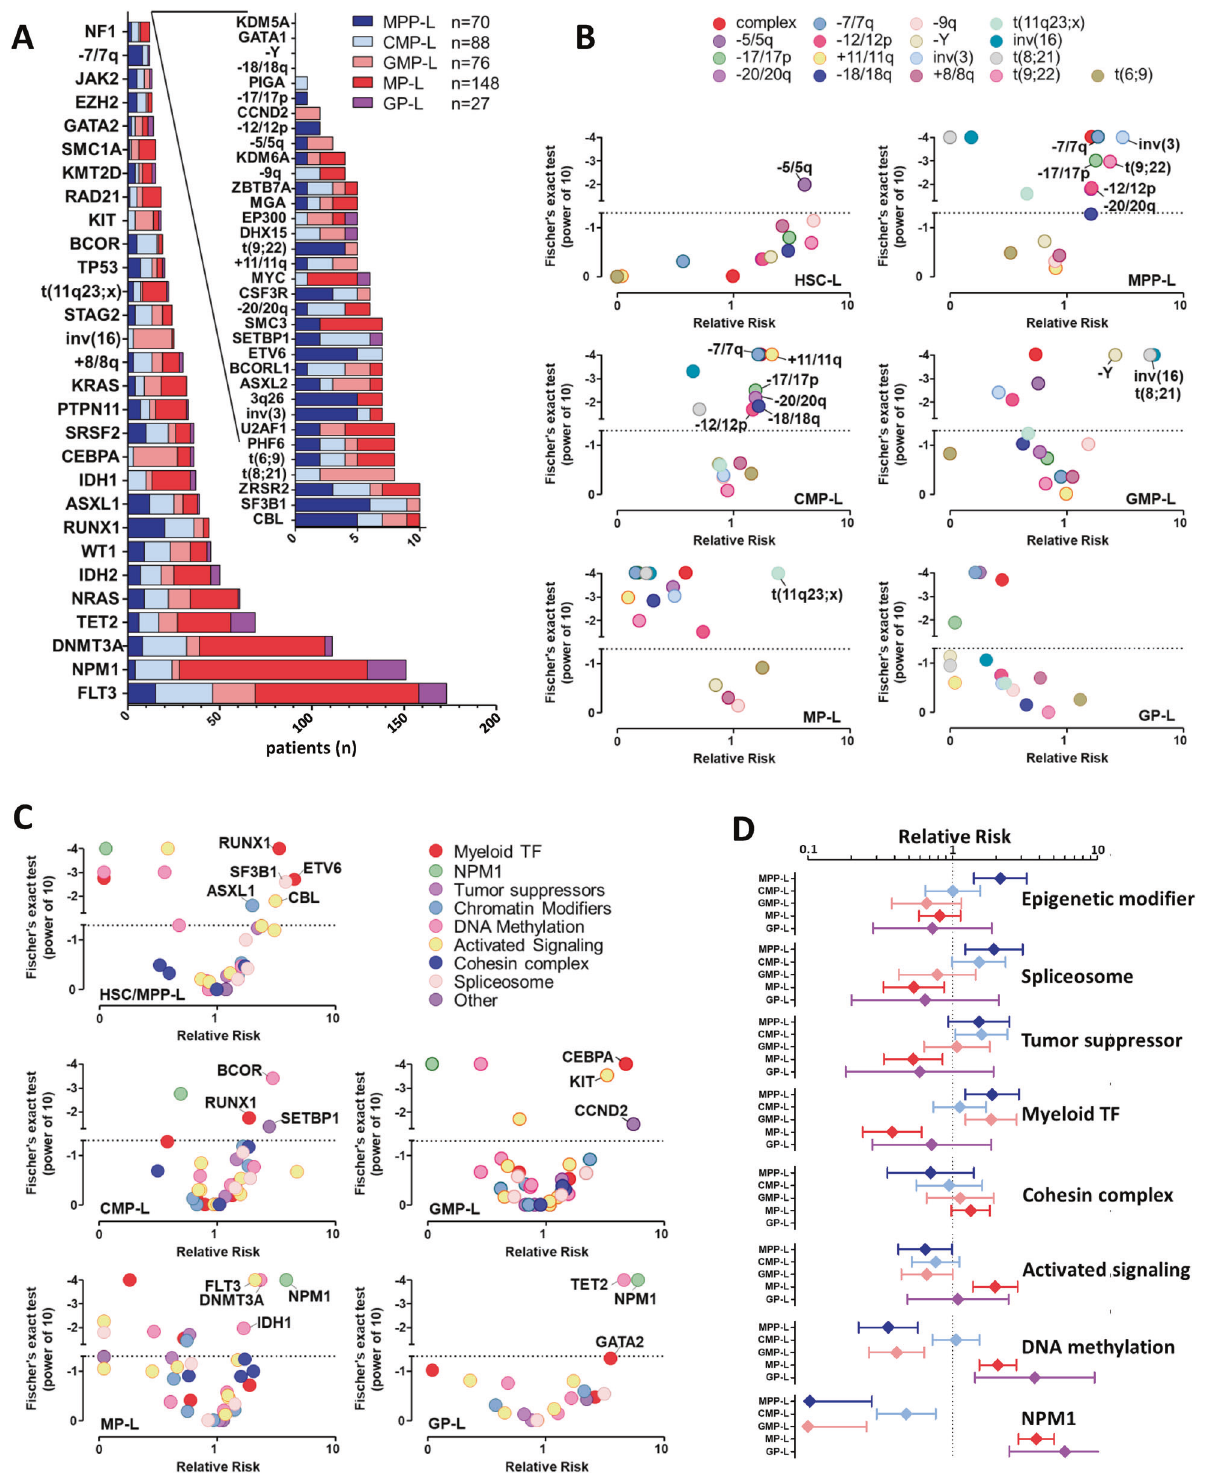
Fig. 4 Distribution of AML mutations and genetic abnormalities according to the SLA. A Number of patients with speci fi c mutations or genetic abnormalities ( n = 409). B Volcano plots of relative risk of the presence of speci fi c genetic anomalies in each SLA ( n = 1967). C Volcano plots of relative risk of the presence of speci fi c mutations in each SLA ( n = 409). D Plots of relative risks of eight functional modules of mutations [35] in